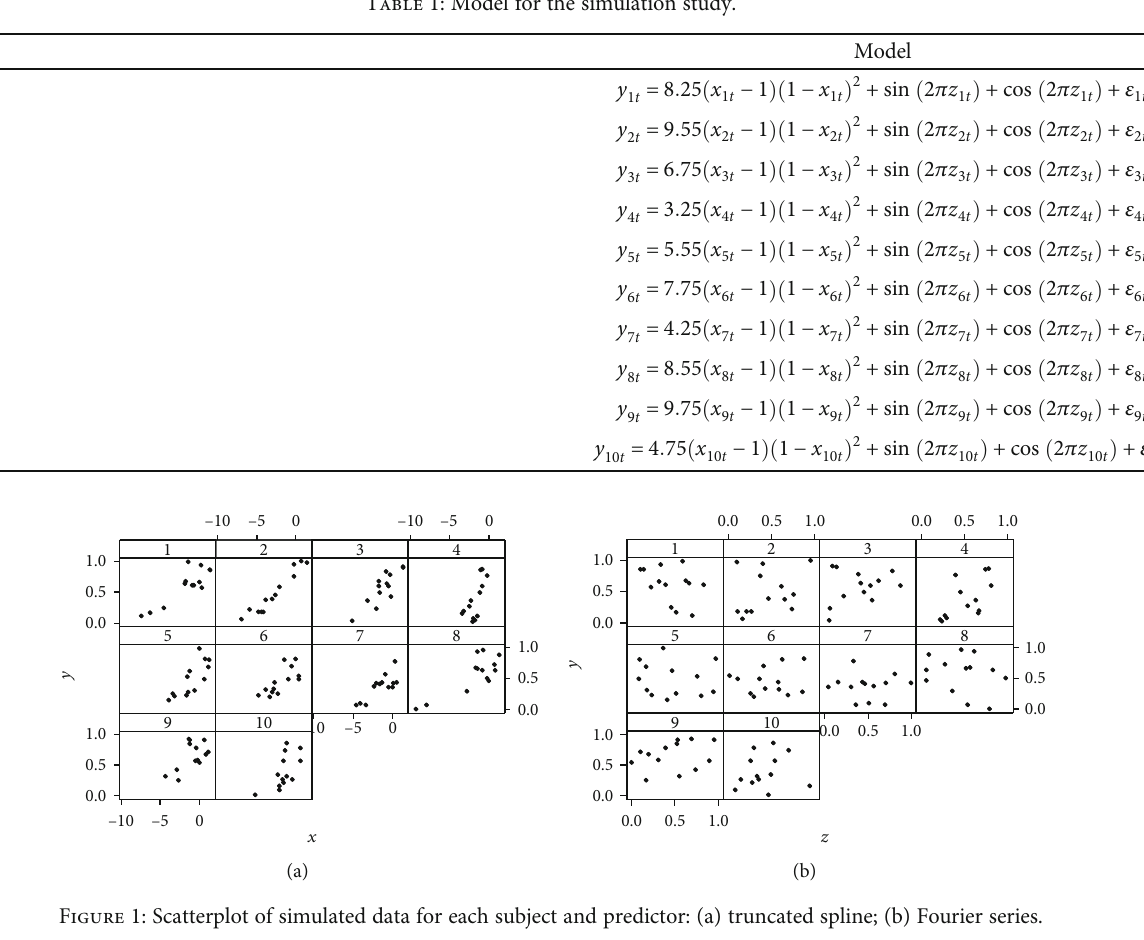
Table 1: Model for the simulation study.